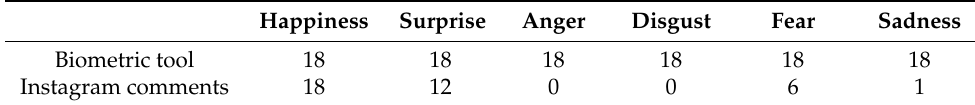
Table 8. Number of GIFs containing each type of emotion by